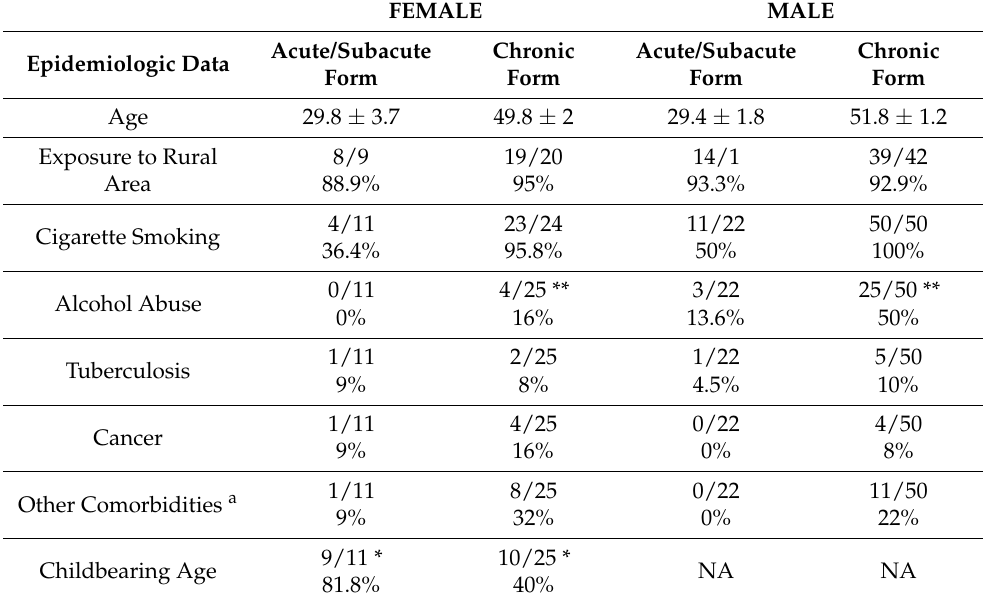
Table 1. Epidemiological data of women and men with